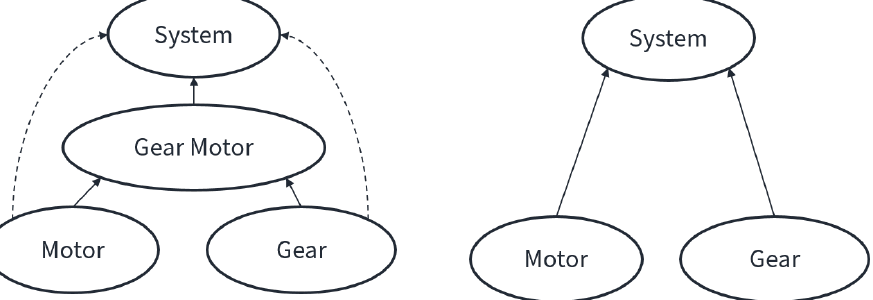
Figure 19. The categories for both possible levels of abstraction of the gear motor.